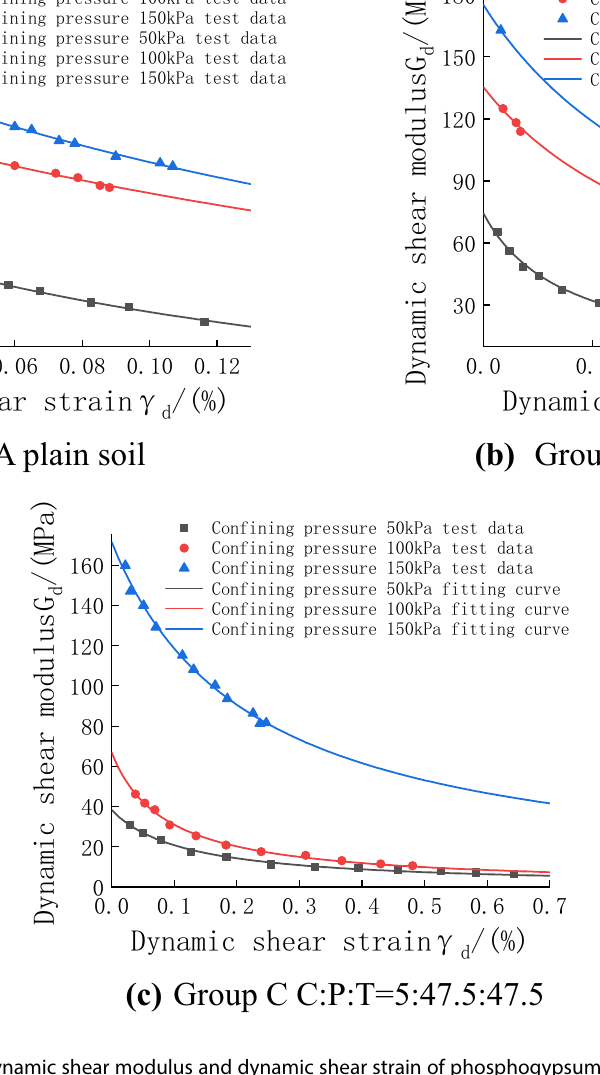
Fig. 9 Relationship between dynamic shear modulus and dynamic shear strain of phosphogypsum stabilized soil under different confining